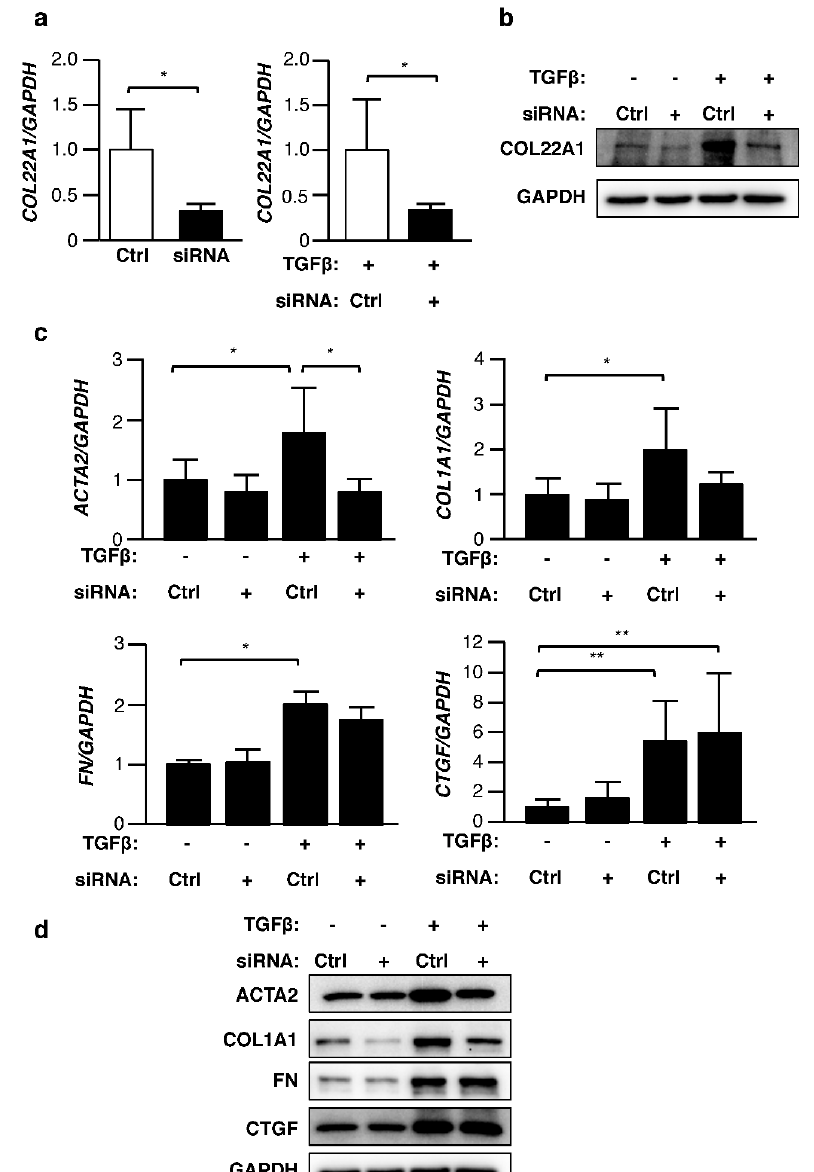
Figure 4. Silencing COL22A1 reduces expression levels of ACTA2. Normal skin fibroblasts were transfected with control or COL22A1 siRNA and treated with TGF β (5 ng/mL) for 48 and 72 h (N = 4). ( a ) Expression levels of COL22A1 mRNA were measured; * p < 0.05. ( b ) Protein levels of COL22A1 were analyzed by immunoblotting of lysates. GAPDH is shown as a loading control. ( c ) Expression levels of fibrosis-related genes were measured; * p < 0.05; ** p < 0.01. ( d ) Representative protein levels in lysates from fibroblasts transfected with control or COL22A1 siRNA.